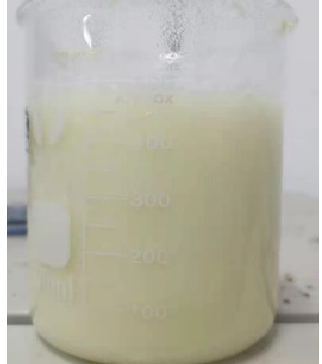
Figure 3. Crude extract solution of soybean urease.